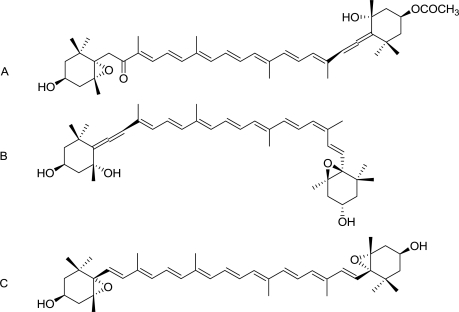
Chemical structures of (A) fucoxanthin, (B) neoxanthin and (C) violaxanthin.